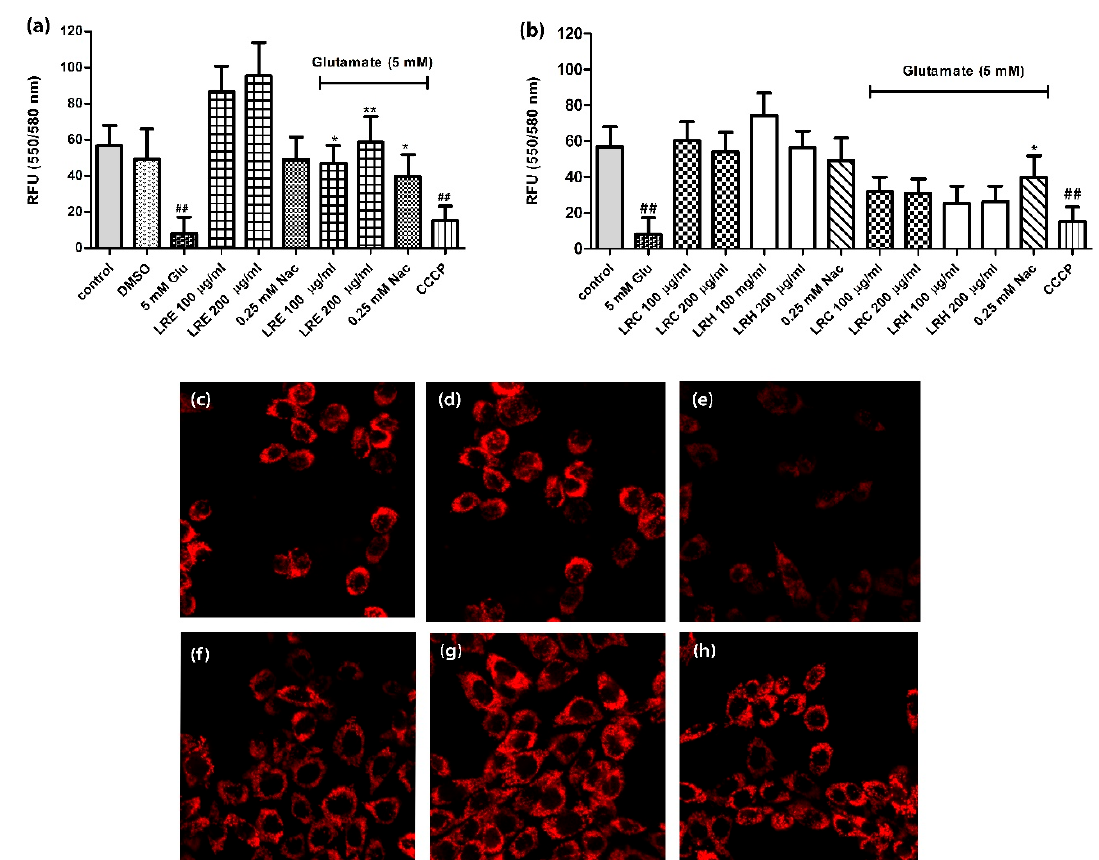
Figure 3. Protective effect of different concentrations of LR extracts on Mitochondrial Membrane Potential (MMP) in HT22 cells. ( a ) Treatment of cells with LRE, N-acetylcysteine (NAC), carbonylcyanide 3-chlorophenylhydrazone (CCCP) and LRE, NAC plus glutamate; ( b ) Treatment of cells with LRH, LRC and LRH, LRC plus glutamate; ( c – h ) Representative fluorescence micrographs with TMRE staining using fluorescence microscopy; ( c ) control group; ( d ) DMSO group; ( e ) 5 mM glutamate group; ( f ) 100 µg/mL LRE co-treatment group; ( g ) 200 µg/mL; ( h ) 0.25 NAC group. Values are mean ± SEM of at least three independent runs. ## p < 0.01 vs. control; * p < 0.05; ** p < 0.01 vs. glutamate alone.